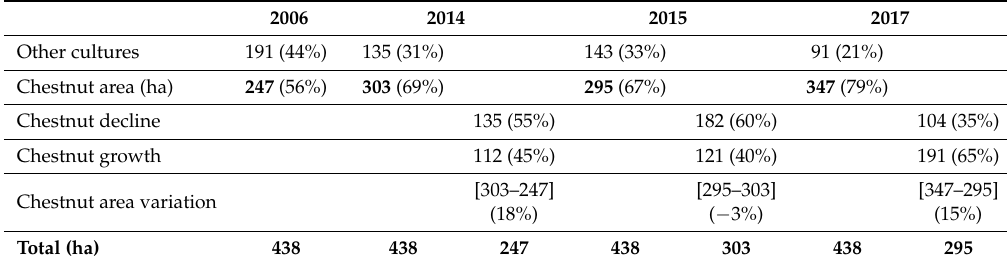
Table 2. Chestnut area and chestnut decline affecting the whole study area (438